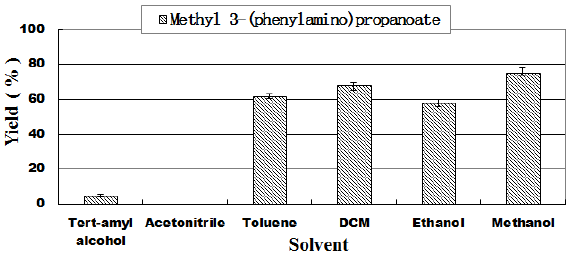
Figure 1. The e ff ect of reaction media on enzymatic synthesis of β -amino acid esters in continuous-flow